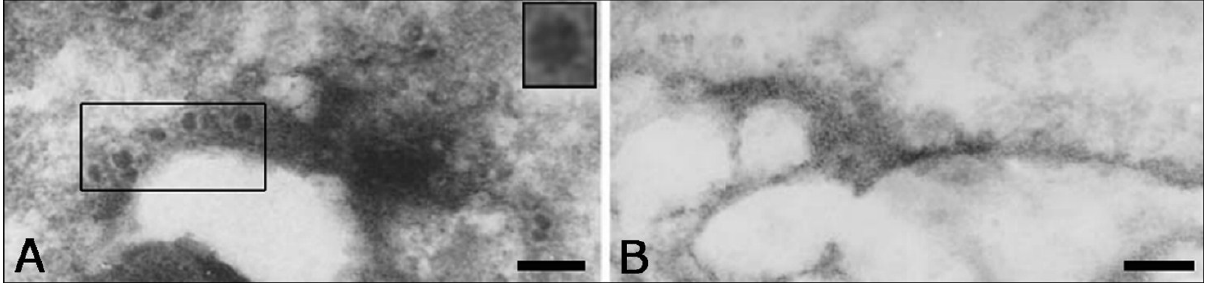
Figure 3. Papaya latex analysis by transmission electron microscopy (TEM). ( A ) Diseased and ( B ) healthy latex samples were studied by TEM, which revealed the PMeV particles (highlight) on the polymers. Inset show the amplified virus particle. The scale bar is 200 nm on both